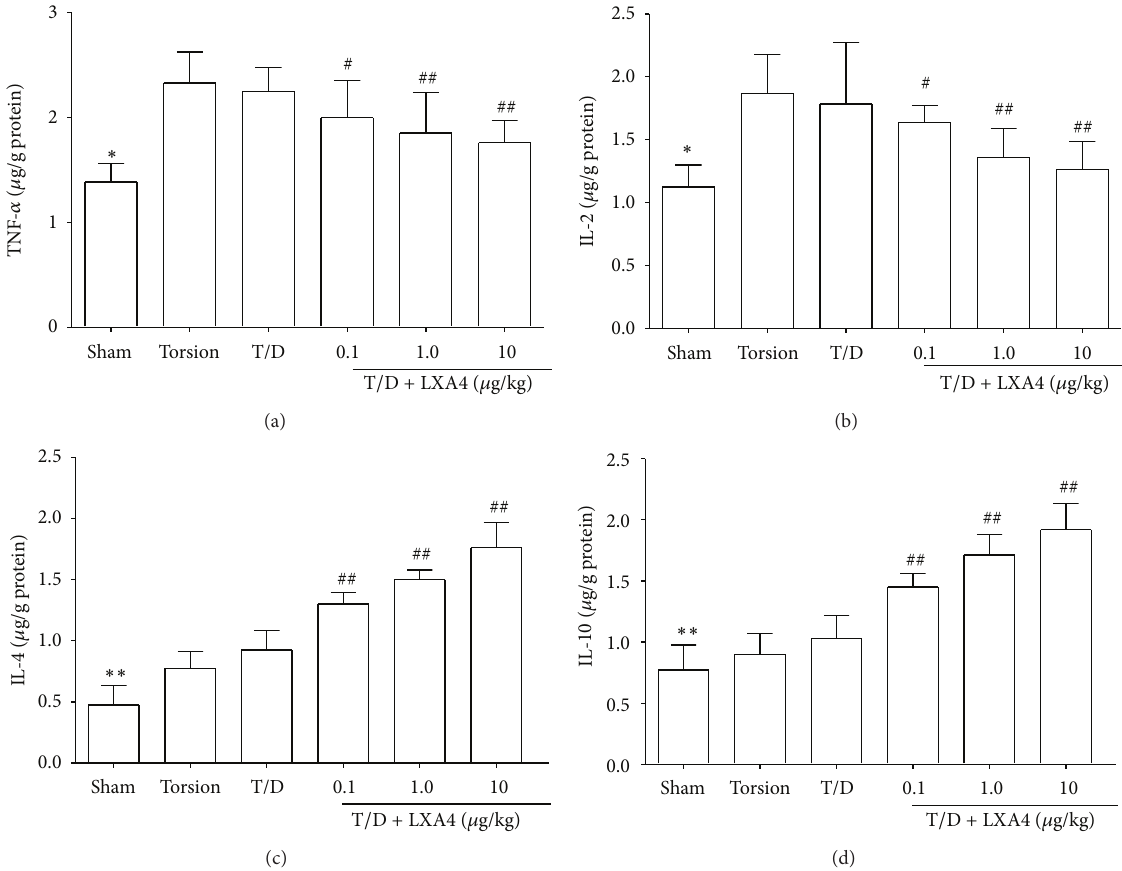
Figure 1: Changes of cytokines in testicular tissue. LXA4 treatment inhibits the increase of proinflammatory cytokines (IL-2 and TNF- 𝛼 ) and promotes the expression of anti-inflammatory cytokines (IL-4 and IL-10) in testes after testicular torsion. Compared with other groups, ∗ 𝑃 < 0.05 and ∗∗ 𝑃 < 0.01 . Compared with torsion or torsion/detorsion (T/D) group, # 𝑃 < 0.05 and ## 𝑃 < 0.01